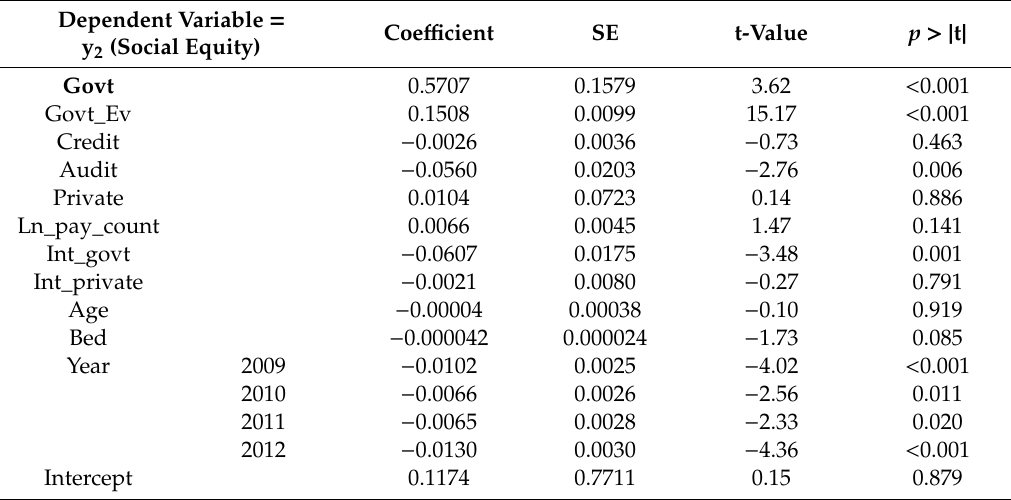
Table 8. Fixed e ff ects regression of publicness on social